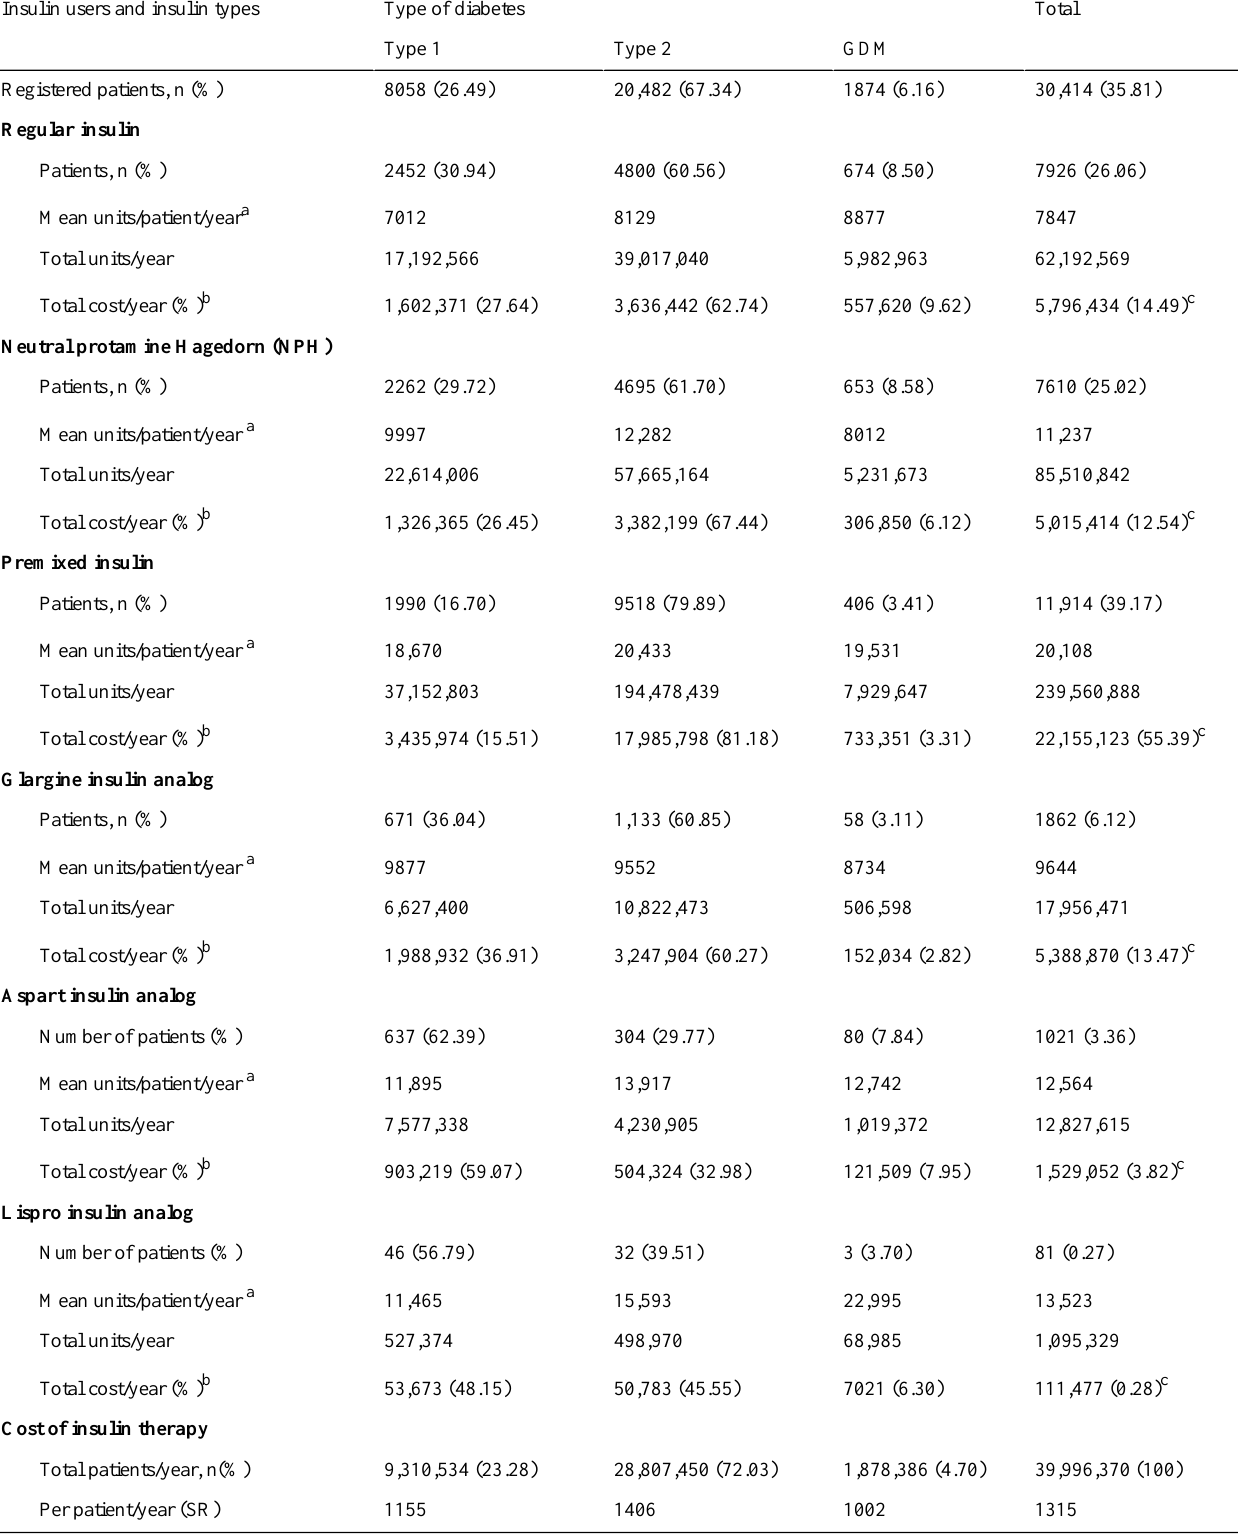
Table 2. Distribution of consumption and cost of different types of insulin according to diabetes type from the Saudi National Diabetes Registry, 2012